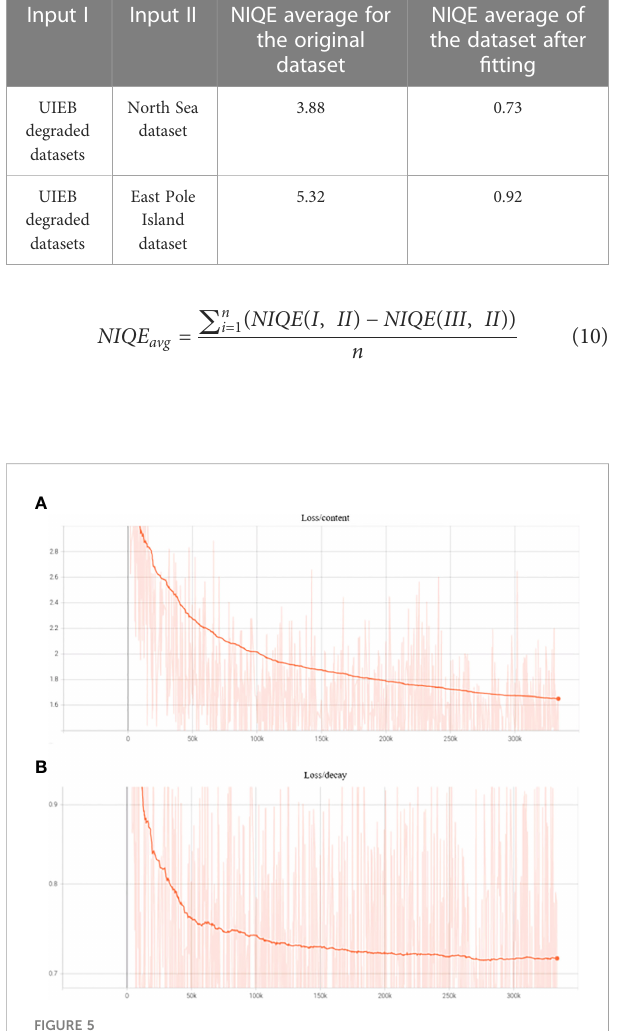
FIGURE 5 Convergence diagrams of the content loss function. (A) is the content loss function. (B) is the ray attenuation loss